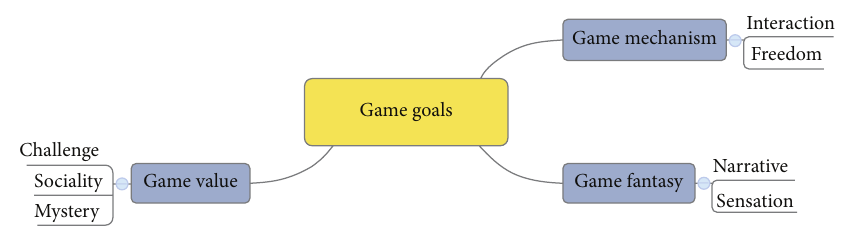
Figure 2: Factor